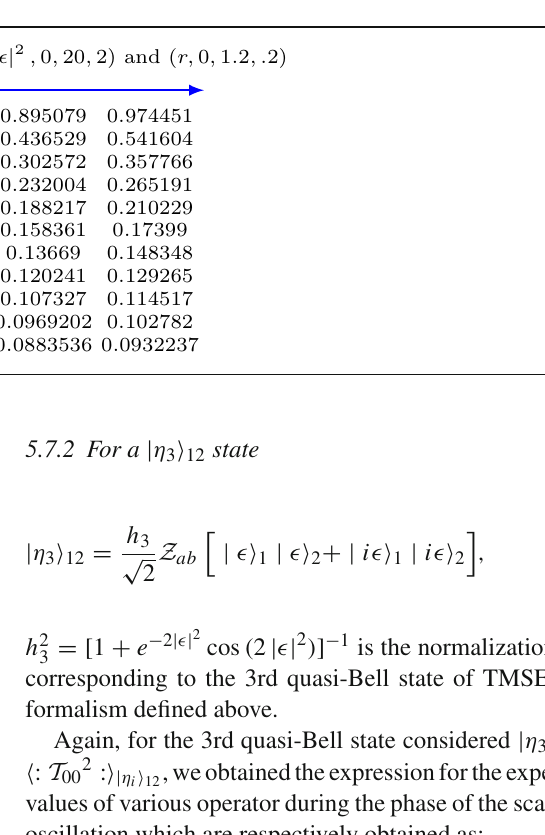
Fig. 15 Figure 14 and this figure are plots for the D T in | η 1 (cid:3) and | η 2 (cid:3) states, plotted as a function of | (cid:11) | and r parameters. Note that | η 1 (cid:3) 12 and | η (cid:3) 2 12 states are semiclassical states with otherwise the states are very quantum with D T ≈